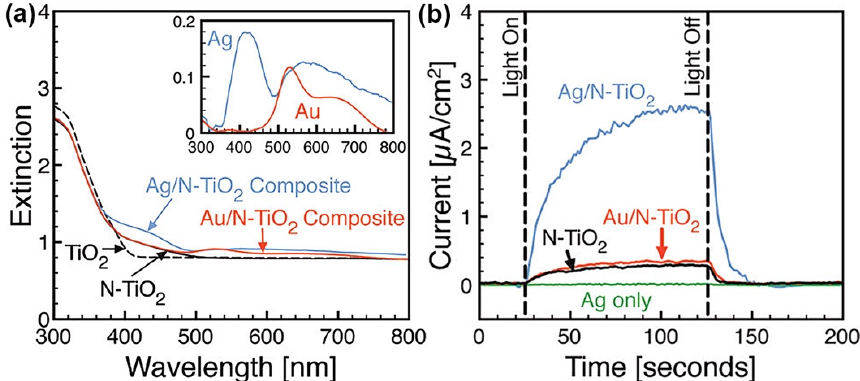
Figure 10. ( a ) Ultraviolet-visible extinction spectra of TiO 2 , N-TiO 2 , Ag/N-TiO 2 and Au/N-TiO 2 samples. The inset shows difference spectra for Ag and Au (i.e., the Ag/N-TiO 2 or Au/N-TiO 2 spectrum minus the N-TiO 2 spectrum); ( b ) Photocurrent responses (per macroscopic electrode area) under visible light illumination. Reproduced from [124], with copyright permission from American Chemical Society, 2011.